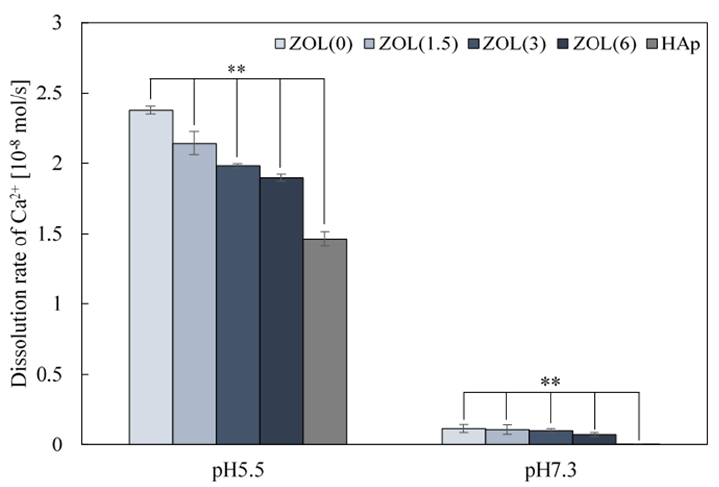
Figure 2. Dissolution of Ca 2+ of the ZOL/ β -TCP powders. Dissolution rate of Ca 2+ of the ZOL/ β -TCP powders in Acetate buffer (pH 5.5) and Tris-HCl buffer (pH 7.3). Error bars indicate standard deviation of the mean. The asterisks show ** p < 0.01 as compared with the dissolution rate of HAp by Student’s t -test.